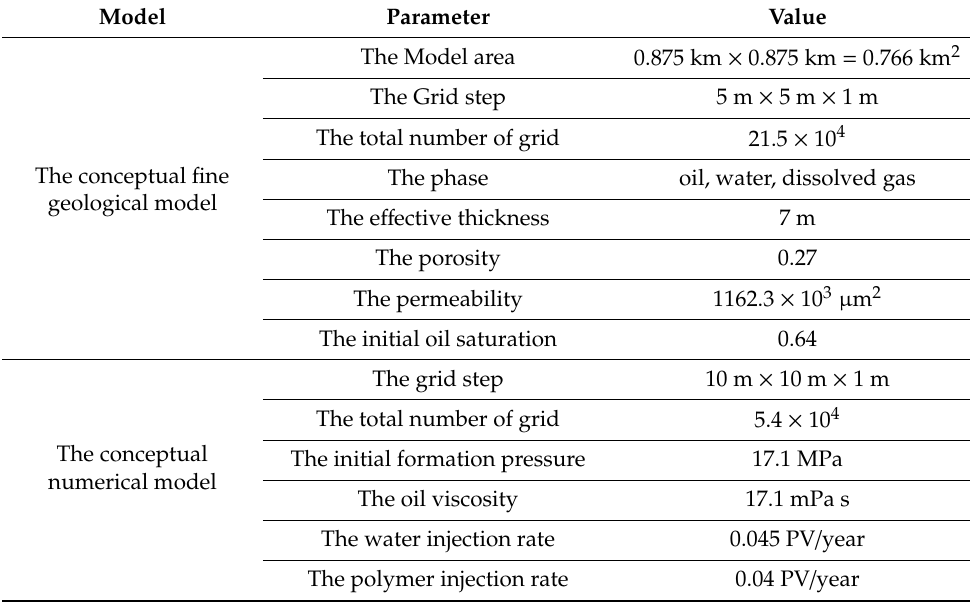
Table 2. The parameters of the conceptual fine geological model and numerical